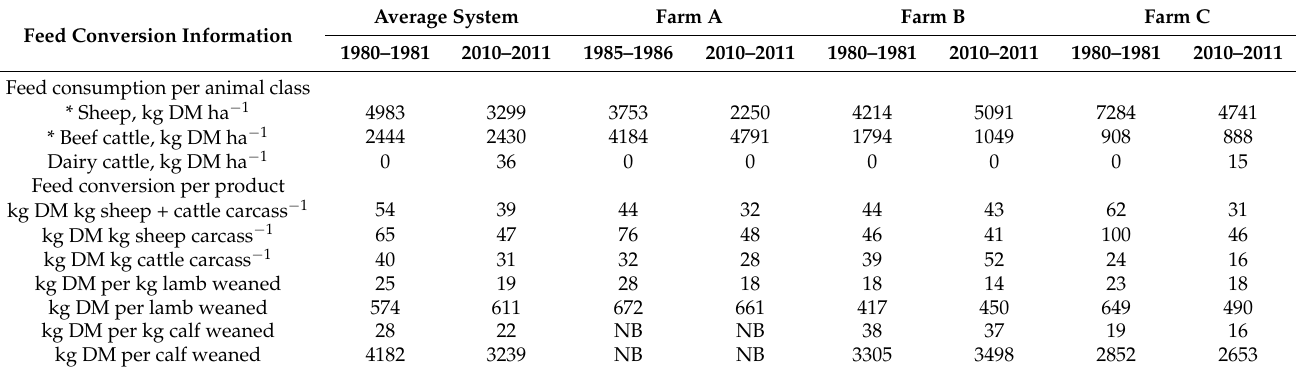
* Sheep and beef cattle on New Zealand Average System are heavier in recent years, meaning meat production per kg DM ha − 1 is also higher. Average System = B+LNZ Class IV, medium slope, New Zealand southern North Island hill country sheep and beef cattle production system as calculated in this study. NB = No breeding